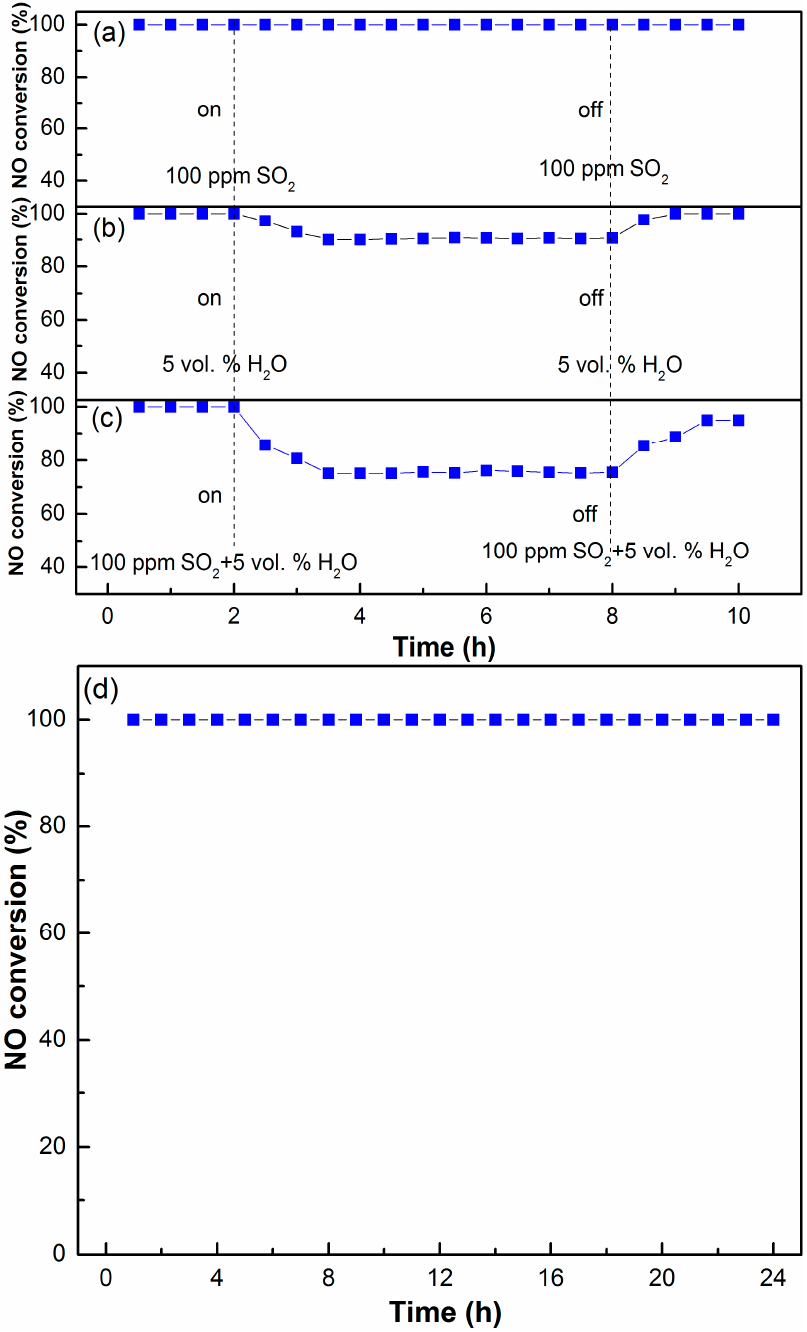
Figure 12. The influence of SO 2 ( a ), H 2 O ( b ), and SO 2 + H 2 O ( c ) on NO conversion and long-time stability test ( d ) of the MCTO-600 catalyst. Reaction conditions: T = 200 °C, 500 ppm of NO, 500 ppm of NH 3 , 5 vol. % of O 2 , 5 vol. % of H 2 O (when used), 100 ppm of SO 2 (when used), and balance N 2 ; GHSV = 14,400 h − 1 . Meanwhile, the H 2 O resistance of the MCTO-600 catalyst was also investigated, as shown in Figure 12b. When 5 vol. % of H 2 O vapor was introduced into the system, the NO conversion decreased from 100% to 90% in the first 2 h and remained stable for the next 4 h, which returned to 100% after the H 2 O vapor was cut off, which may have been due to the fact that the adsorption of